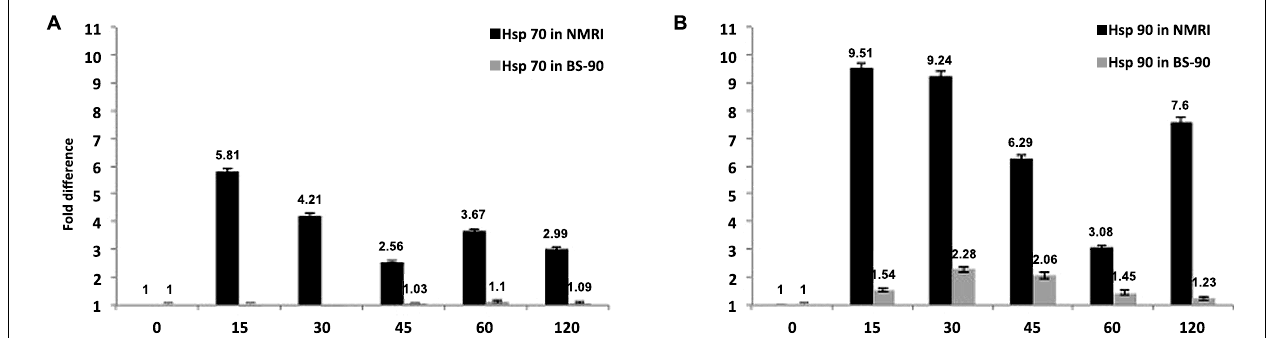
FIGURE 1 |Temporal modulation of the transcript encoding (A) Hsp 70 or (B) Hsp 90 in susceptible NMRI and resistant (BS–90) B. glabrata snail stocks examined by qPCR after exposure (0 – 120 min) to S. mansoni